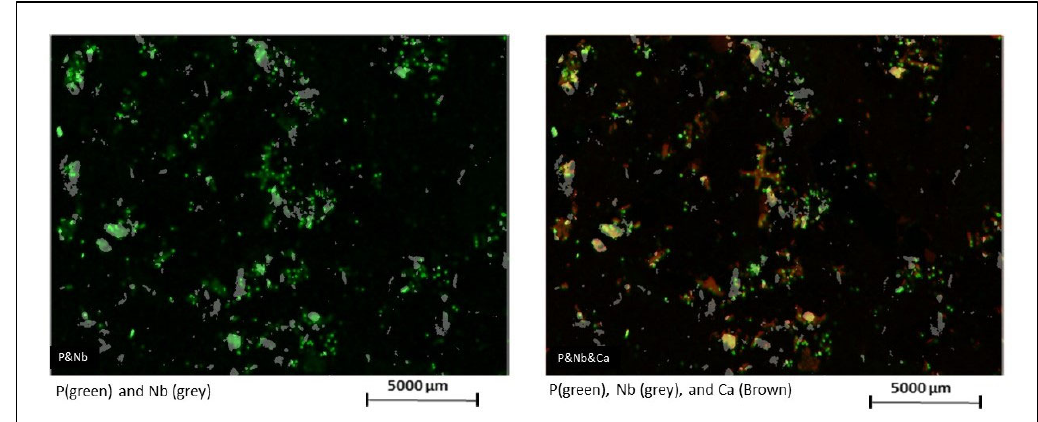
Figure 14. Elemental spatial micrometric distributions of P&Ca and Nb&Ca.